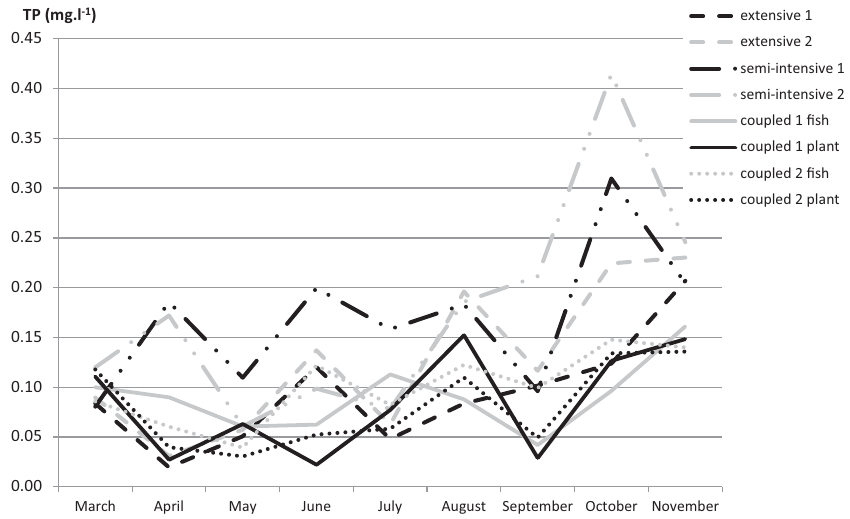
Fig. 6. Total phosphorus (TP) dynamics in the water TP during the rearing period in two replicates of carp polyculture ponds: extensive (without formulated feed), semi-intensive (with feed and double fi sh density) and coupled (semi-intensive ( fi sh) þ planted lagoon